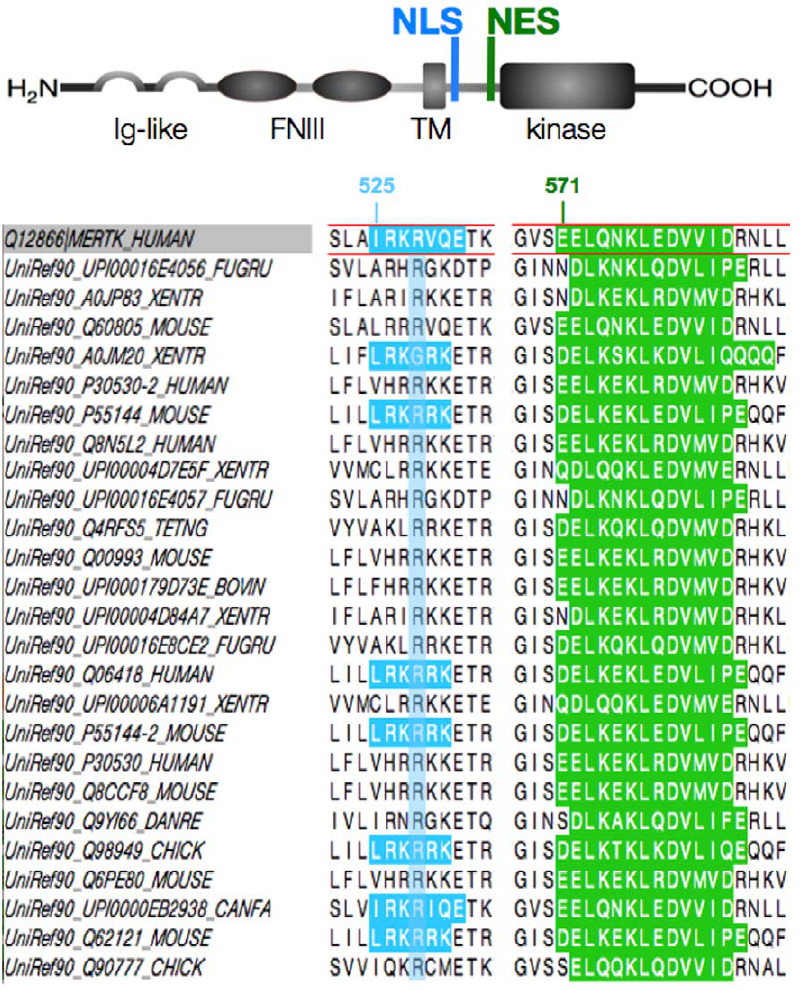
Figure 7. Mer contains conserved nuclear localization and export signals. Above, a diagram of Mer protein structure depicts the nuclear localization signal (NLS) and nuclear export signal (NES) within the juxtamembrane region of its intracellular domain. Additional functional domains are labeled accordingly (Ig, immunoglobulin; FNIII, fibronectin type III; TM, transmembrane). Below, sequence alignment highlights conservation of the C-extended monopartite variant NLS ( blue ) and the leucine-rich NES ( green ) among TAM receptors in both human and other species. Residue positions are indicated above the human Mer sequence outlined in red. Motif analysis and sequence alignment were performed using ELM [22] and Jalview software